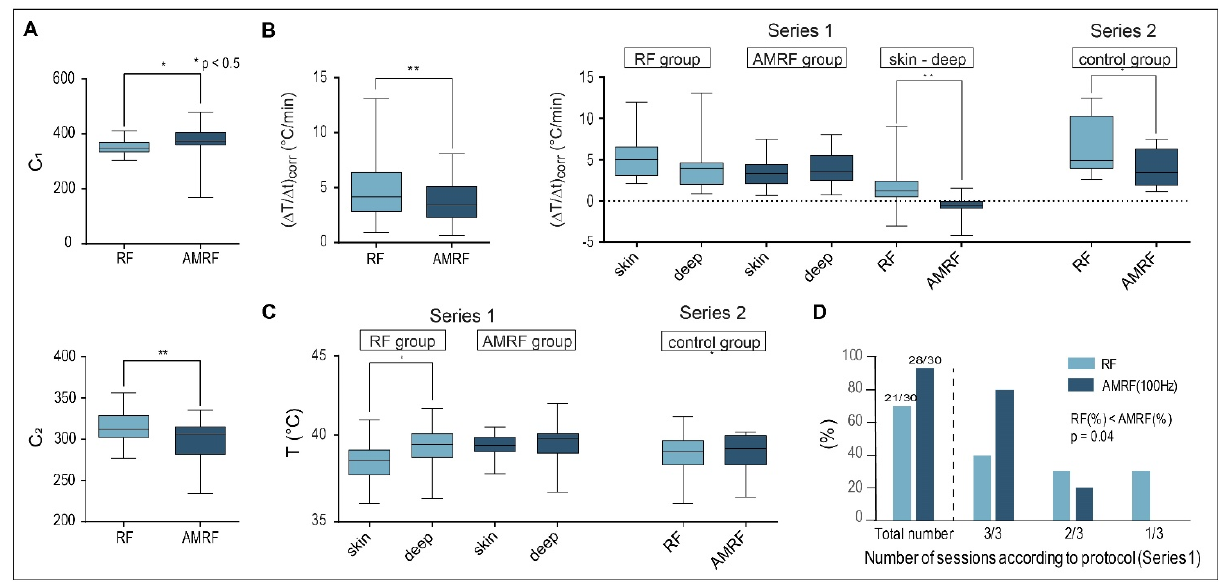
Figure 6. ( A ) Tuning capacitances in vivo. Values obtained for C 1 and C 2 in vivo show the same qualitative behavior as those achieved in vitro (Figure 1B,C), with even higher statistical significance. We included all completed RF and AMRF treatments in this analysis. ( B ) Corrected power deposition in vivo. The initial temperature gradients ( Δ T/ Δ t) corr (corrected for the dissipated power) in vivo behave similar to the in vitro measurements (Figure 3A) if all RF and AMRF measurement points were compared. The temperature gradients as a function of the locations (superficial versus deep in the tumor center) and techniques (RF versus AMRF) suggest that the thermally relevant power density is higher and more nonhomogeneous for RF in comparison to AMRF. ( C ) Location- dependent temperatures in vivo. Mean T max in tumor-related superficial and intratumoral deep measurement points broken down by RF (light) and AMRF (dark) for series 1 (left panel) and series 2 (right panel). Even though the thermal power is less for AMRF, the measured temperatures are comparable and more homogeneous. ( D ) Feasibility and tolerance. Three sessions per mouse were intended in series 1 (RF group versus AMRF group with 2 × 10 mice). The number of successfully completed sessions is significantly higher in the AMRF group. Significance was defined as p < 0.05 and marked with * (< 0.005 with **, etc.)